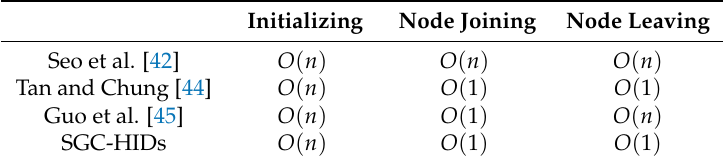
Table 3. Computation time complexity for each phase in each